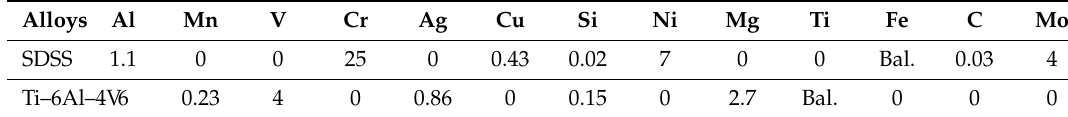
Table 1. Chemical composition (wt %) of the alloys studied.